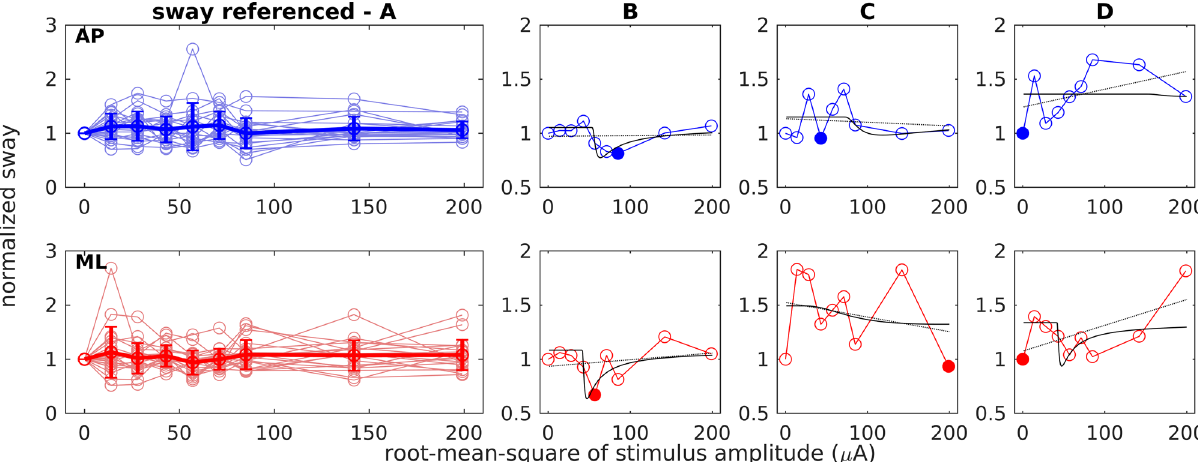
Figure 4. Normalized body sway path for standing with sway-referencing at varying nGVS intensities. Top row (AP, blue) shows anterior–posterior sway. Bottom row (ML, red) shows medio-lateral sway. ( A ) Responses of all subjects (light circles and lines) with group mean and standard deviation (thick line). ( B–D ) Three exemplary individual responses including the linear (grey) and the SR curve fit (black). Filled circles indicate minimum values. ( B ) Performance curve showing a SR-like bell-shaped with optimal improvement at an intermediate nGVS intensity. ( C ) Performance curve showing only optimal improvement at a particular nGVS intensity. ( D ) Performance curve showing none of the two.